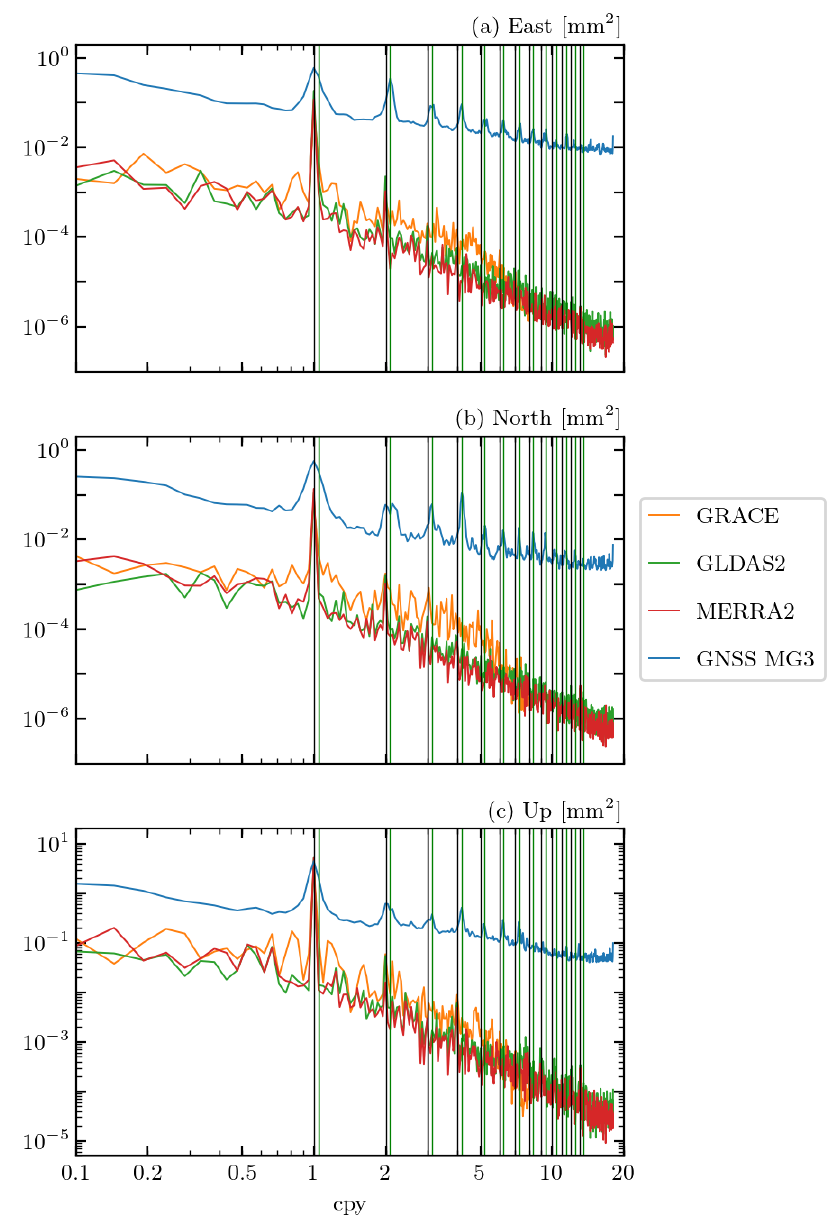
Figure 11. Lomb–Scargle periodograms for the three loading models and the detrended MG3 GNSS solution. The periodograms of all stations were stacked and then divided by the number of stations in order to obtain mean periodograms for each solution. The vertical black lines indicate the solar cycle harmonics, and the vertical green lines indicate the draconitic